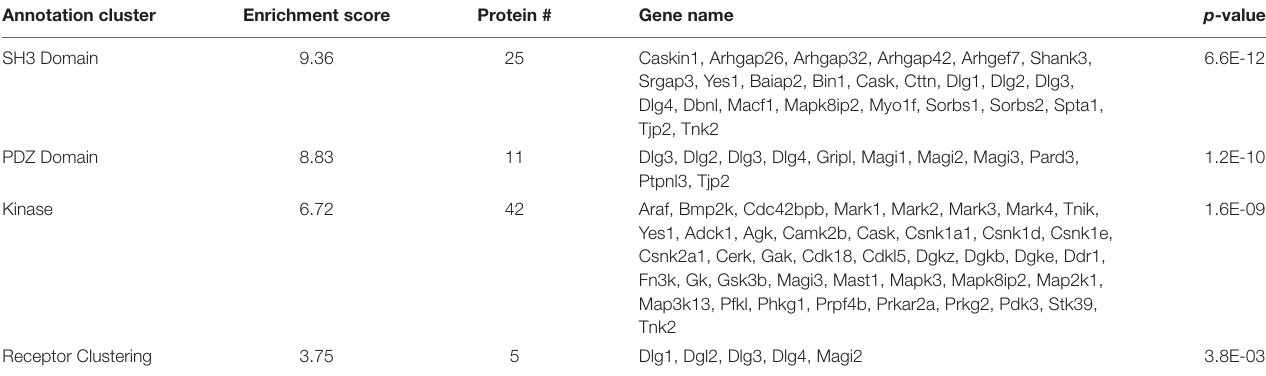
TABLE 4 | DAVID functional analysis of all identified